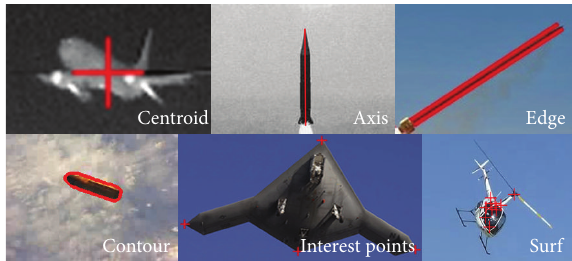
Figure 7: Examples of feature location.